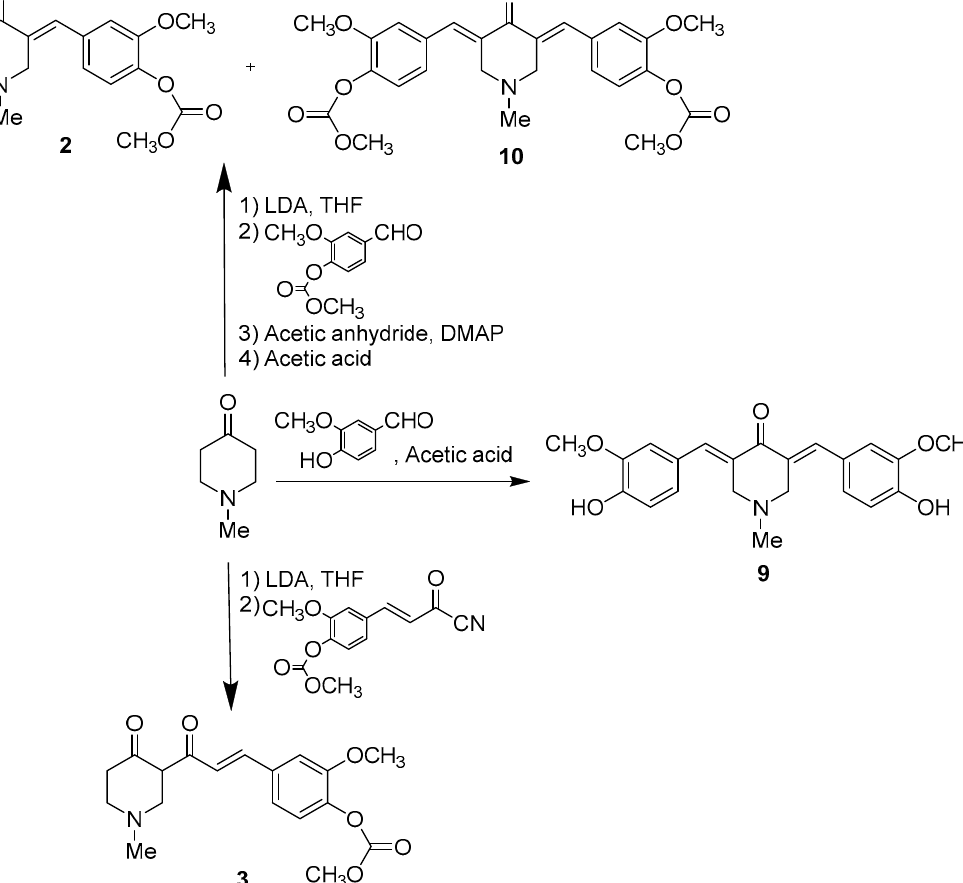
Table 1. The values of percent superoxide anion scavenging by curcumin and its